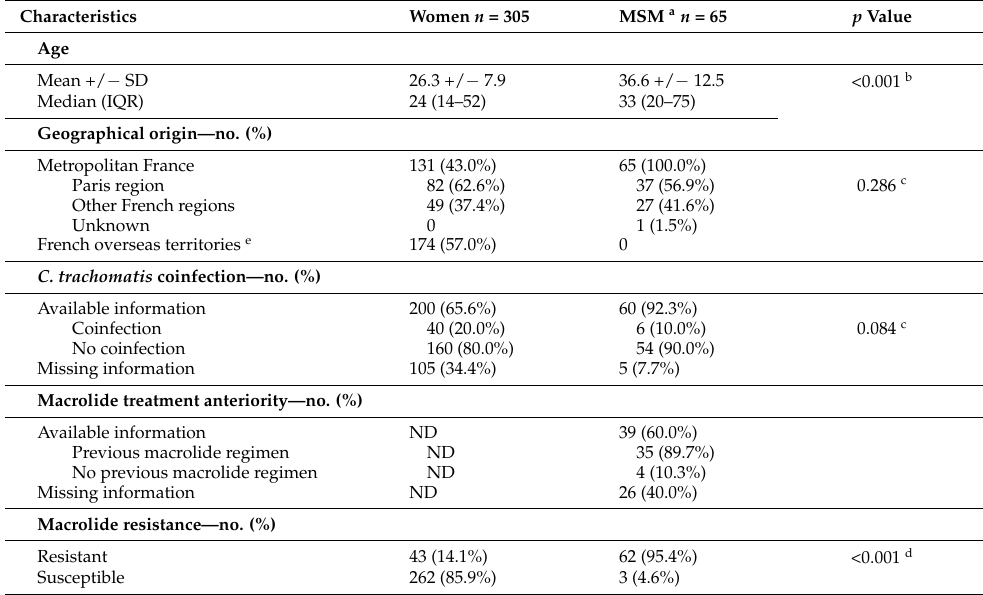
Table 1. Characteristics of the 370 M. genitalium -positive patients with successful mgpB typing results.